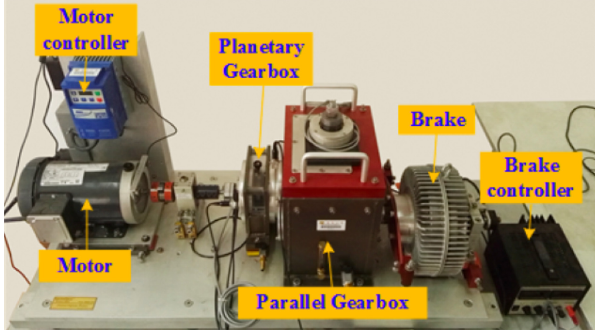
Figure 9. Experimental setup for the SEU dataset [44].